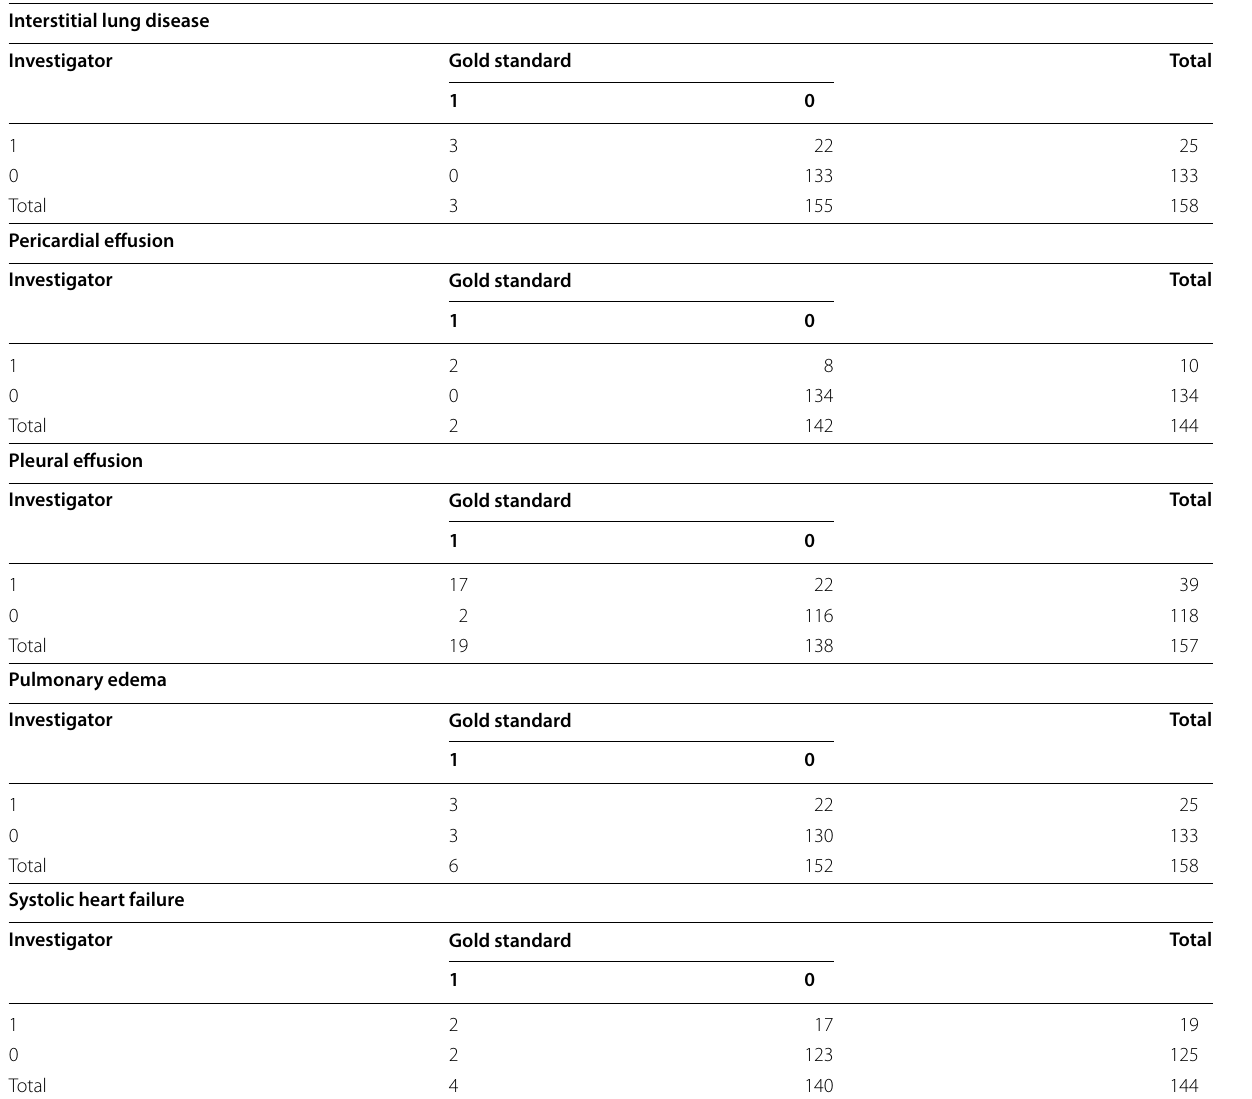
Table 4 Per protocol: correlation and diagnostic accuracy between investigators pathological ultrasonography findings and gold standard pathology Interstitial lung